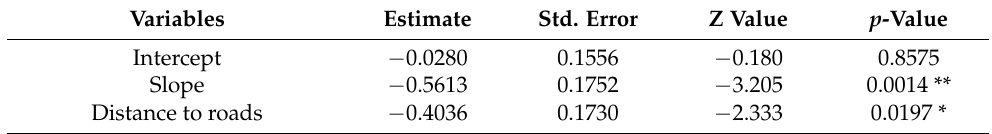
Table 5. Result of the logistic regression predicting tropical forest loss to agriculture with variables of slope and distance to roads. ‘*’ Significant at 0.05 level, ‘**’ significant at 0.01 level. Variables Estimate Std. Error Z Value p -Value Intercept − 0.0280 0.1556 − 0.180 0.8575 Slope − 0.5613 0.1752 − 3.205 0.0014 ** Distance to roads − 0.4036 0.1730